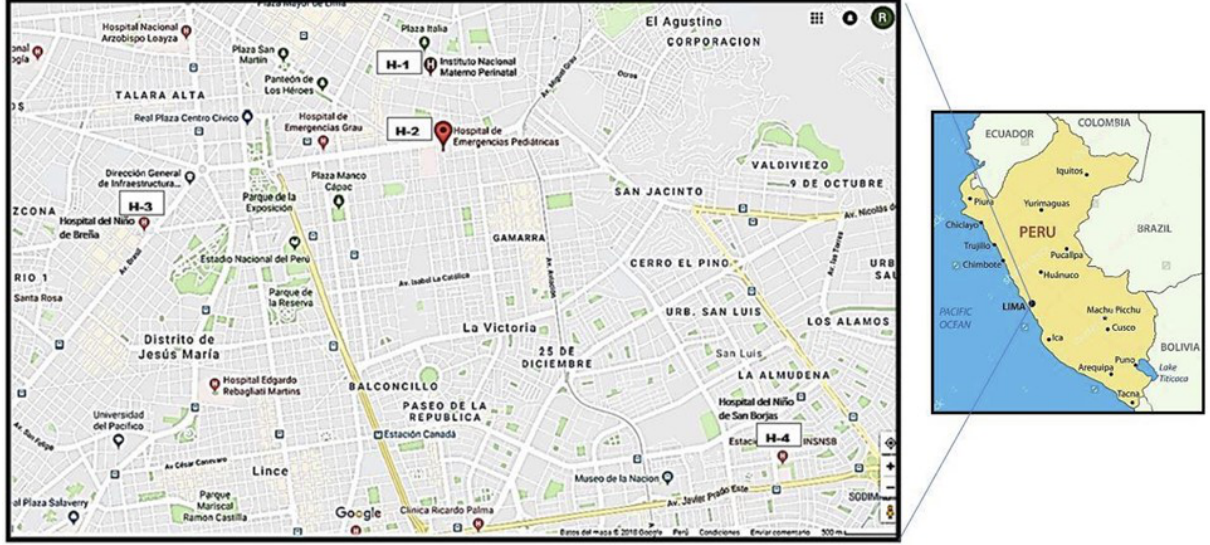
Figure 1: General Location of the Four Hospitals that are the Objects of this Study H-1: National Maternal Perinatal Institute; H-2: Paediatric Emergencies Hospital; H-3: Breña’s Children’s Hospital; H-4: San Borja’s